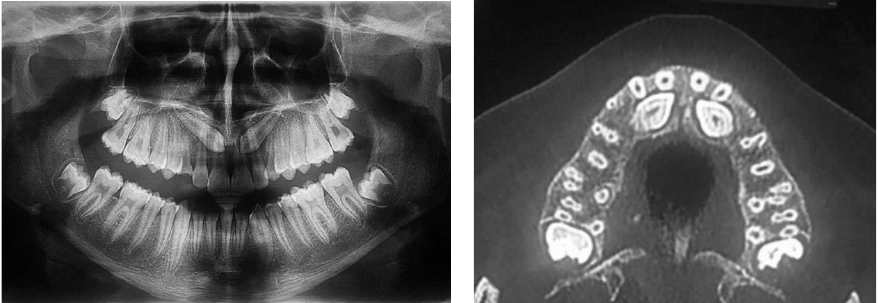
Figure 1. An RX orthopantomography ( left ) and a CBCT ( right ) of a patient with two palatally impacted canines. The major axis of the canine and its perpendicularity to the alveolar margin, which represents the axis of the canine in its presumed ideal position, were plotted on the OPT.